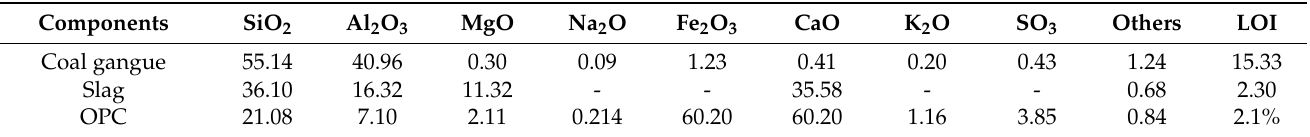
Table 1. Main compositions of test materials